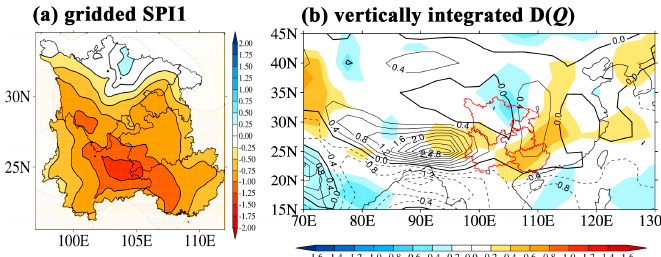
Figure 4. Composite of: ( a ) gridded SPI1; and ( b ) vertically integrated water vapor flux divergence (D( Q ); contours) and its standardized anomalies (SA; shadows) during drought processes in Southwest China (SWC). The unit of D( Q ) is 10 − 4 ·kg·s − 1 ·m − 2 .